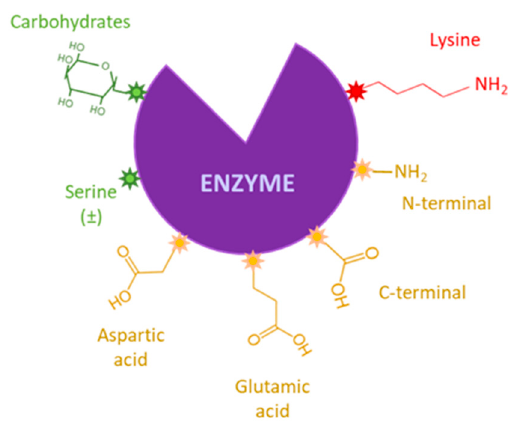
Figure 7. Scheme of amino acids that can serve as anchors in immobilization. Red: Used very frequently; yellow: Frequently used; green: Not frequently used. Adapted from [28].